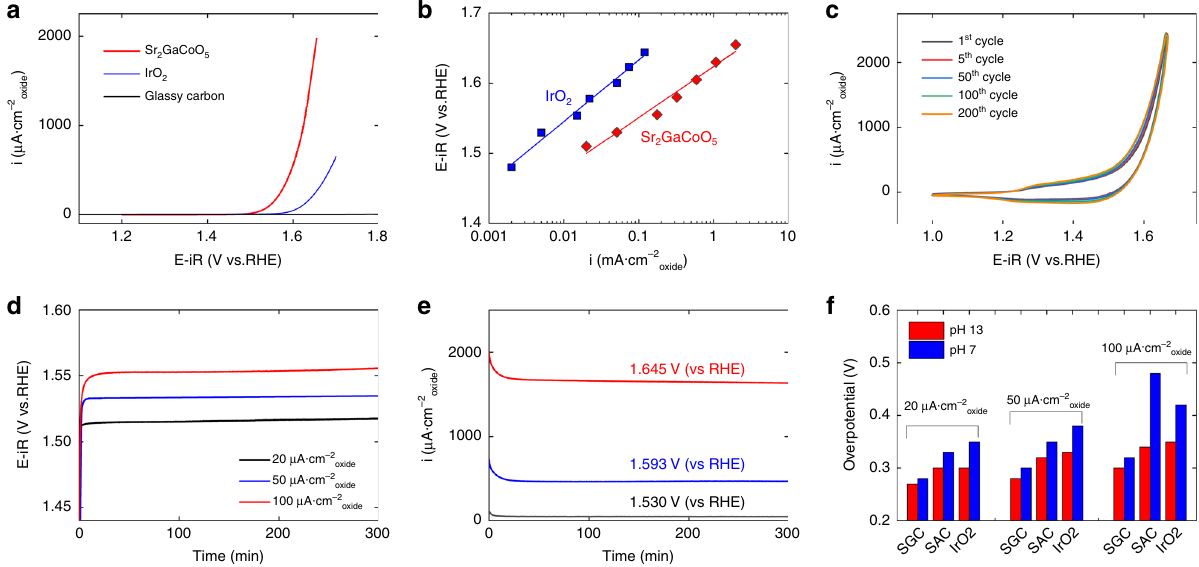
Fig. 2 Performance of Sr 2 GaCoO 5 towards oxygen evolution in neutral-pH. a Linear sweep voltammogram of Sr 2 GaCoO 5 , commercial IrO 2 and blank electrode with only glassy carbon and ink. All current densities were normalized based on the surface area measured in Brunauer – Emmett – Teller analysis, 8.4 m 2 ·g − 1 for Sr 2 GaCoO 5 and 32.0 m 2 g − 1 for IrO 2 . The current for the blank electrode was normalized to the surface area of Sr 2 GaCoO 5 loaded on the electrode. b Tafel plot of Sr 2 GaCoO 5 and commercial IrO 2 . The data is fi tted with the equation i ¼ i 0 exp ½ α V (cid:2) V 0 ð Þ(cid:3) , where i 0 is the preexponential factor and V 0 is the equilibrium voltage. c Cyclic voltammetry of Sr 2 GaCoO 5 . No appreciable change was observed during 200 repeated scans. d Galvanostatic experiments at constant current densities. The overpotentials at constant current densities of 20, 50, and 100 μ A·cm − 2 oxide was stabilized at 0.28, 0.30 and 0.32 V, respectively. e Potentiostatic experiments at constant voltages. The capacity retention after fi ve hours of operation was 94 – 96%. f Comparison of the overpotentials for Sr 2 GaCoO 5 , Sr 2 AlCoO 5 , and IrO 2 at the same current densities in pH 7 and pH 13 solutions